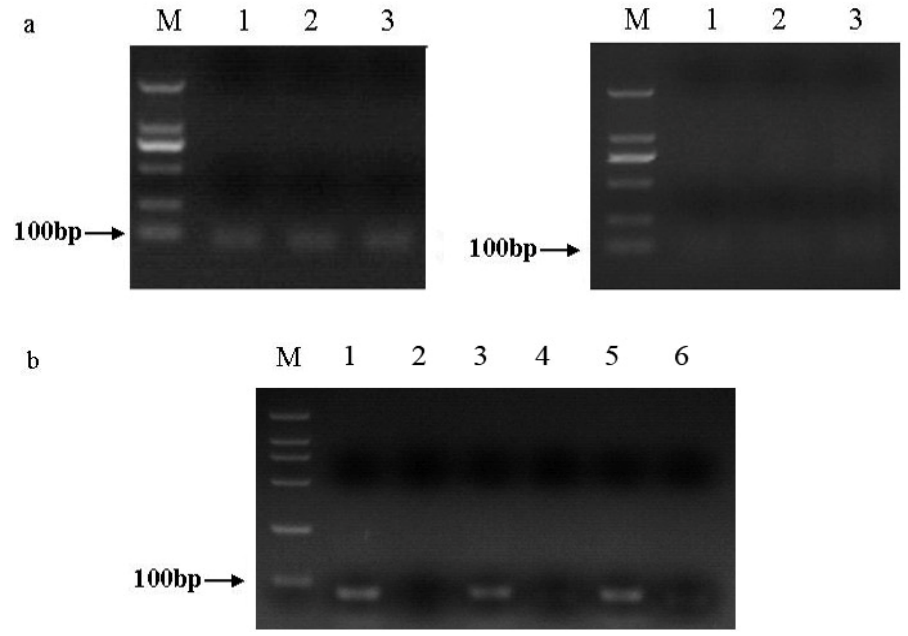
Figure 1. ( a ) Performance of Groups 1 primers by stem-loop RT-PCR. The bands size is amplified as shown by the arrow along with a 100 bp DNA marker ( M ). Left are PCR products of putative miR-2a (1), bantam (2), and miR-14 (3) of S. litura which were 89 bp, 89 bp, 86 bp, respectively, and their corresponding minus-RT control are shown on the right; ( b ) Performance of Groups 2 primers by stem-loop RT-PCR. The bands size is amplified as shown by the arrow along with a 100 bp DNA marker ( M ). PCR products of putative miR-2a (1), bantam (3), and miR-14 (5) of S. litura were 79 bp, 79 bp, 76 bp, respectively, and minus-RT control by using primers of miR-2a (2), bantam (4), and miR-14 (6) were shown besides the putative